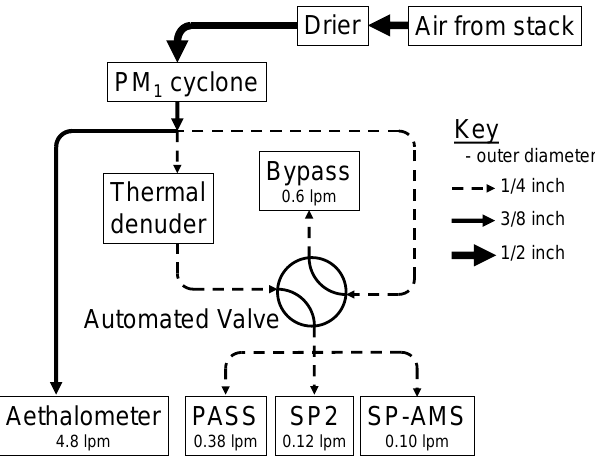
Figure 1. Schematic of the sampling system used for the Univer- sity of Manchester instruments during CalNex, showing the instru- ments’ sample flows. Stainless steel Y-pieces were used when split- ting flows. Before the thermodenuder and bypass flow were set up, the Aethalometer flow rate was 5.4Lmin − 1 to ensure sufficient flow through the